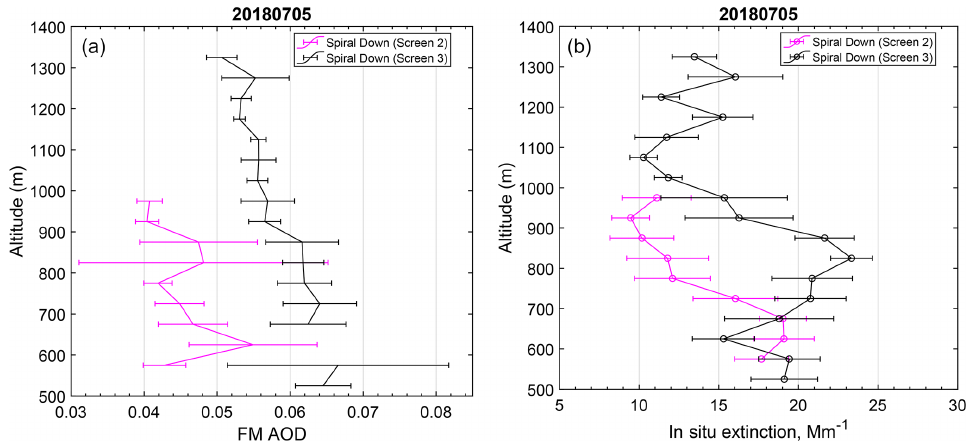
Figure 10. In-plume binned profile data obtained on 5 July during screens 2 and 3. The error bars represent standard deviations within each 50m bin. (a) 4STAR FM AOD, (b) calculated in situ extinction coefficient at 500nm. The in situ layer AOD between 575 and 975m has increased by 0.002 ( ∼ 33%) from screen 2 to screen